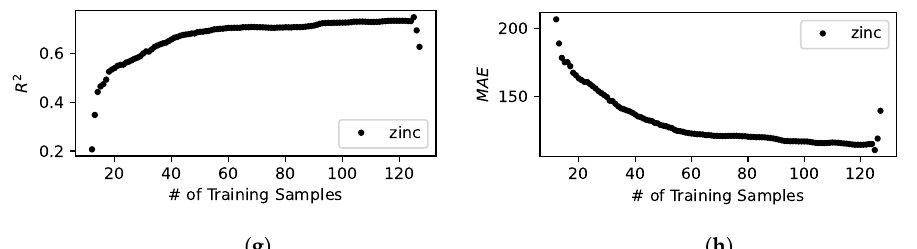
Figure 5. Combined interpolation and prediction model built with active learning. The figures show R 2 and MAE for predicted heavy metal concentrations on the evaluation data set. ( a ) R 2 for predicted cadmium concentration; ( b ) MAE for predicted cadmium concentration; ( c ) R 2 for predicted copper concentration; ( d ) MAE for predicted copper concentration; ( e ) R 2 for predicted lead concentration; ( f ) MAE for predicted lead concentration; ( g ) R 2 for predicted zinc concentration; ( h ) MAE for predicted zinc concentration.